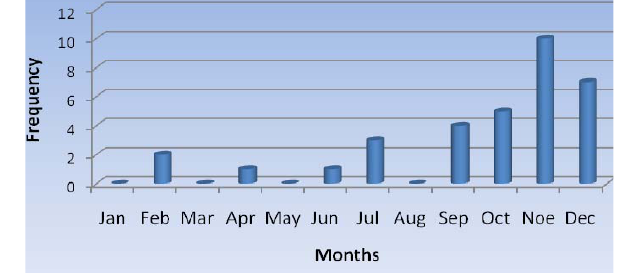
Figure 2 . Monthly variability of tornado activity in Greece within the 20 th century. Fig. 2. Monthly variability of tornado activity in Greece within the 20th century.